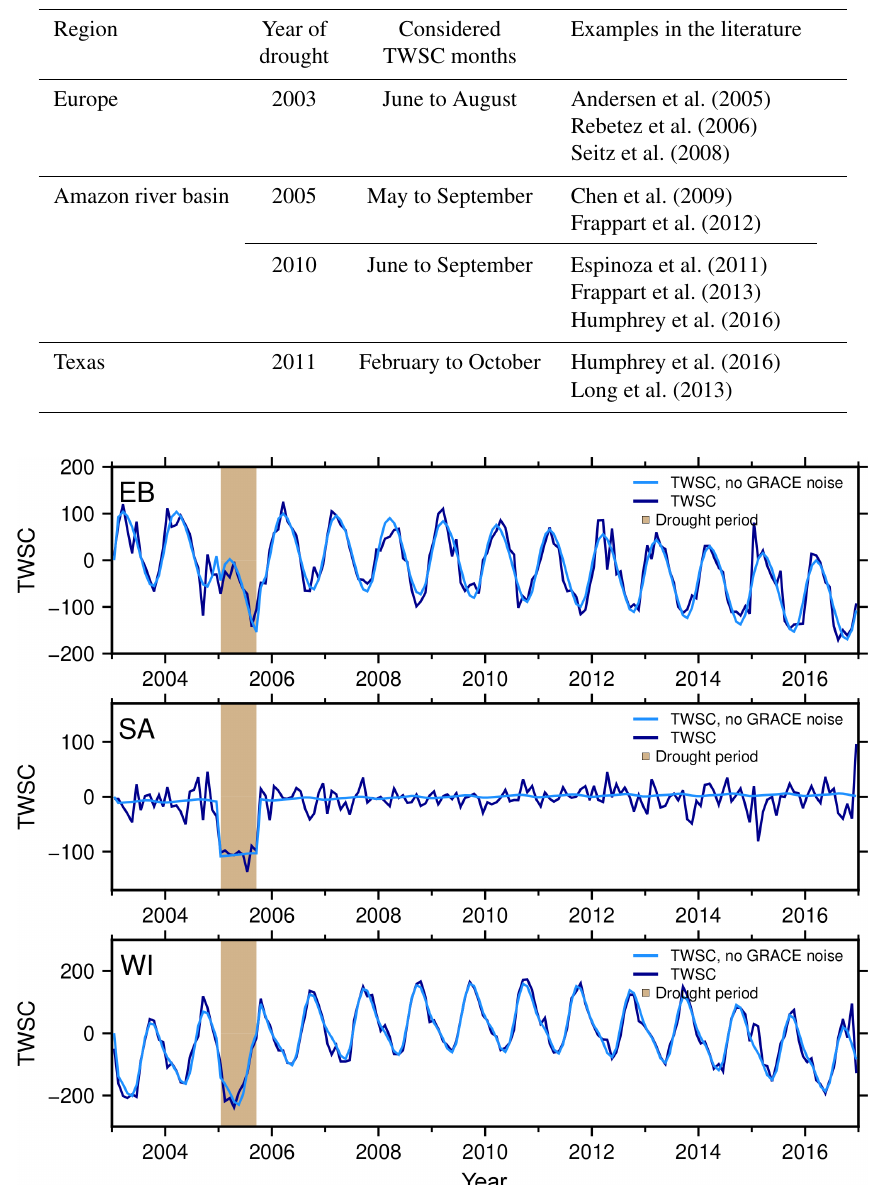
Figure 5. Synthetic TWSC (mm) without (light blue) and with spatial GRACE noise (dark blue) using average parameters for the clusters in eastern Brazil (EB), southern Africa (SA), and western India (WI). Light brown shows the simulated drought